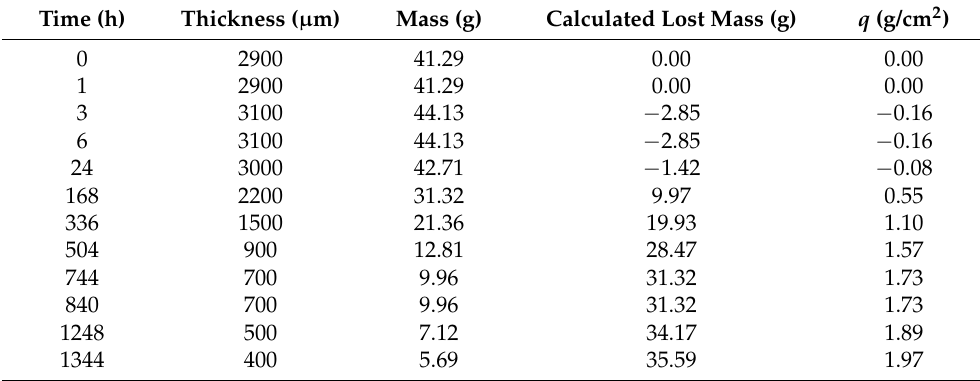
Figure 7. NaCl solution containing the steel plate corrosion products at different times. Table 3. Determination of the q factor, the ratio between the calculated lost mass and the area of the application region of the corrosive solution.